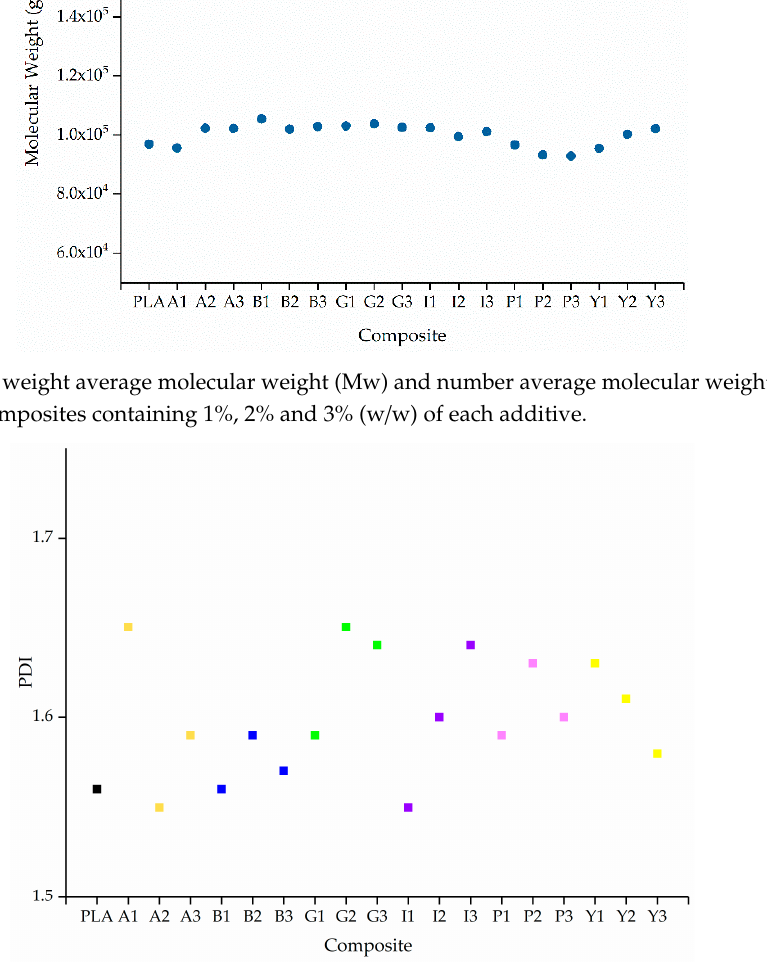
Figure 11. The polydispersity indices (PDI) of PLA and its composites containing 1%, 2% and 3% (w/w) of each additive. The colored squares indicate the different dyes/pigments for visual clarity.